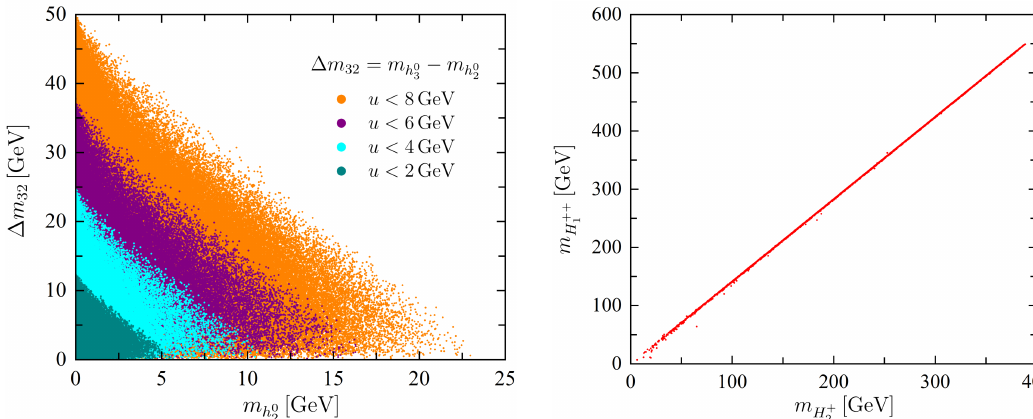
) for values of the triplet VEV u ≤ 8 , 6 , 4 , 2 GeV 2